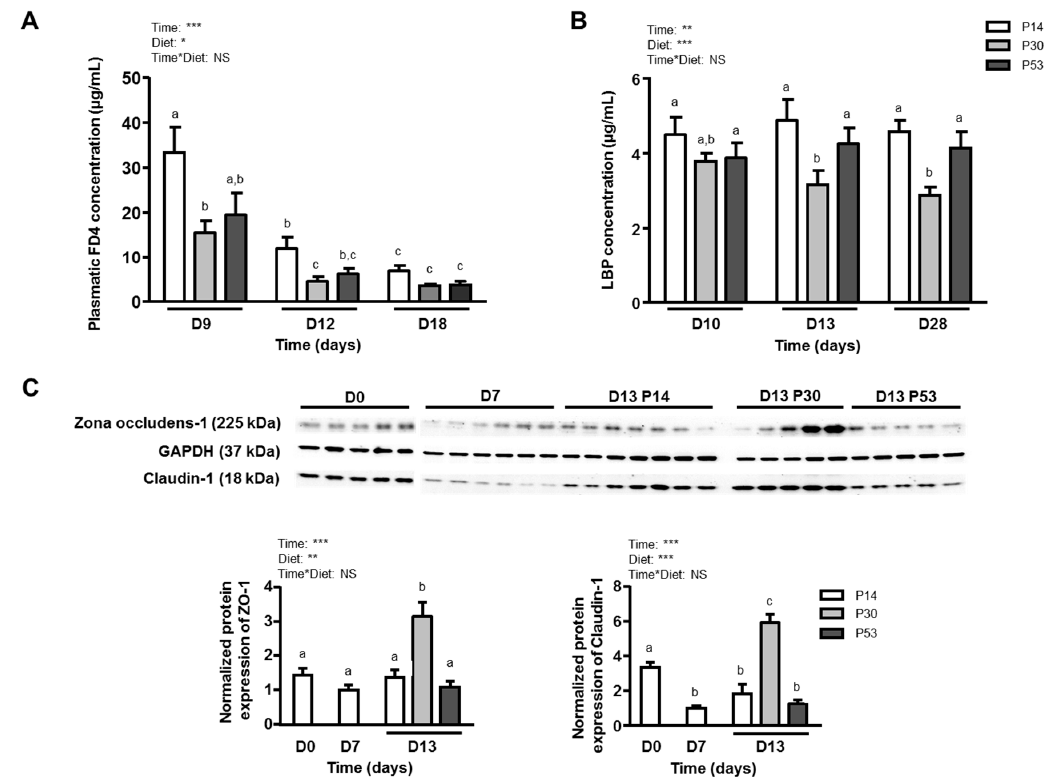
Figure 4. Effects of dietary protein intake level on barrier function after dietary intervention with P14, P30 or P53 diet. ( A ): Evolution of plasmatic FD4 concentration. ( B ): Plasmatic concentration of LPS-binding protein (LBP). ( C ): Western-blot analysis of the tight junction proteins Zona Occludens-1 and Claudin-1, was performed in colonic homogenates of day 13 mice. GAPDH was used as loading control. Images are representative of four Western blots. Means that are significantly different ( p < 0.05) according to the post-hoc test have different letters (a or b or c). Values are means ± SEM ( n = 10–12). *: p < 0.05; **: p < 0.01; ***: p < 0.001; NS: non-significant difference.